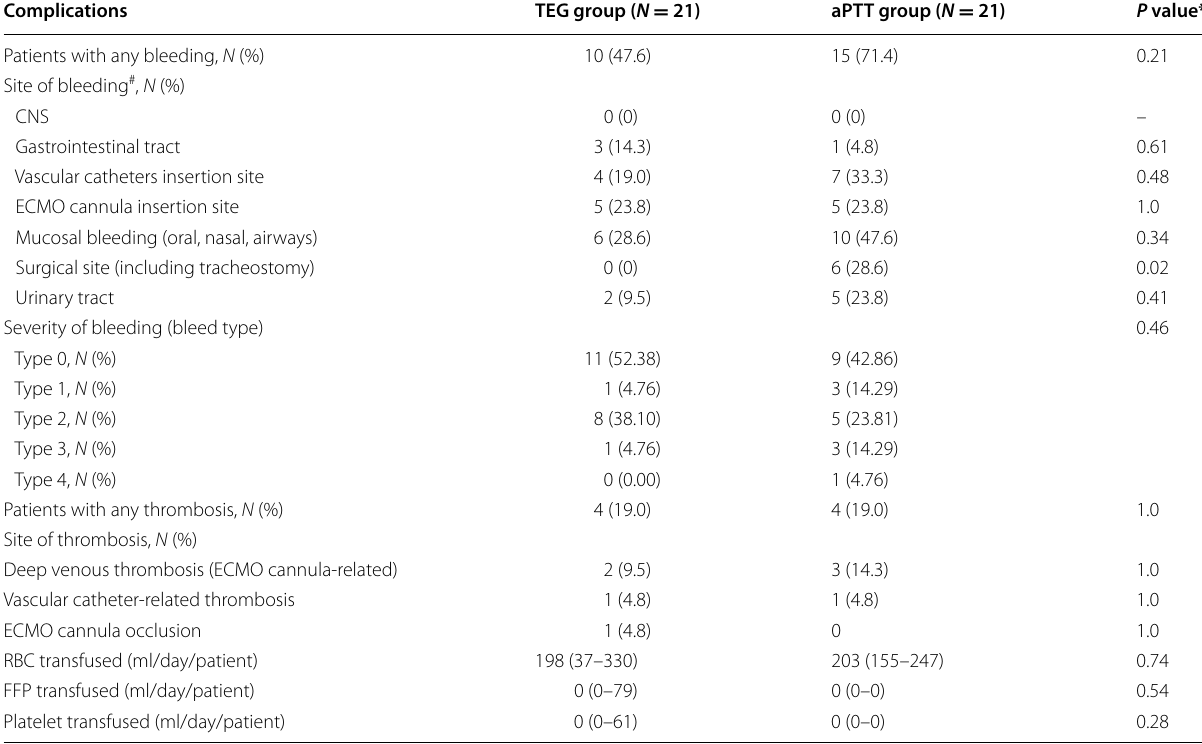
Table 3 Hemorrhagic and thrombotic complications